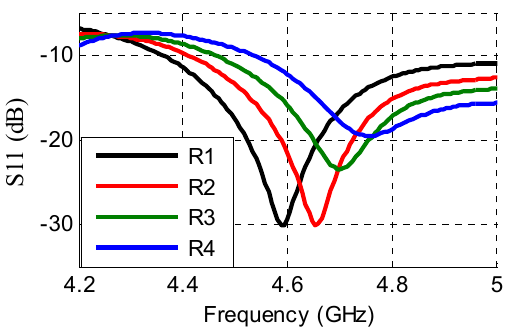
Figure 14. Return loss of antenna integrated with sensor with conductivity values at different time instances obtained from experimental data. R1 = 280 Ω , R2 = 200 Ω , R3 = 166 Ω , and R4 = 136 Ω .